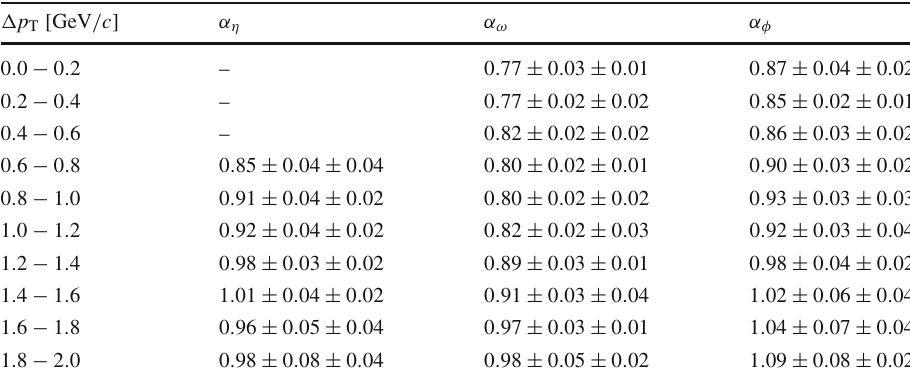
Table 2 Results for the α parameter as a function of p T for the η , ω and φ